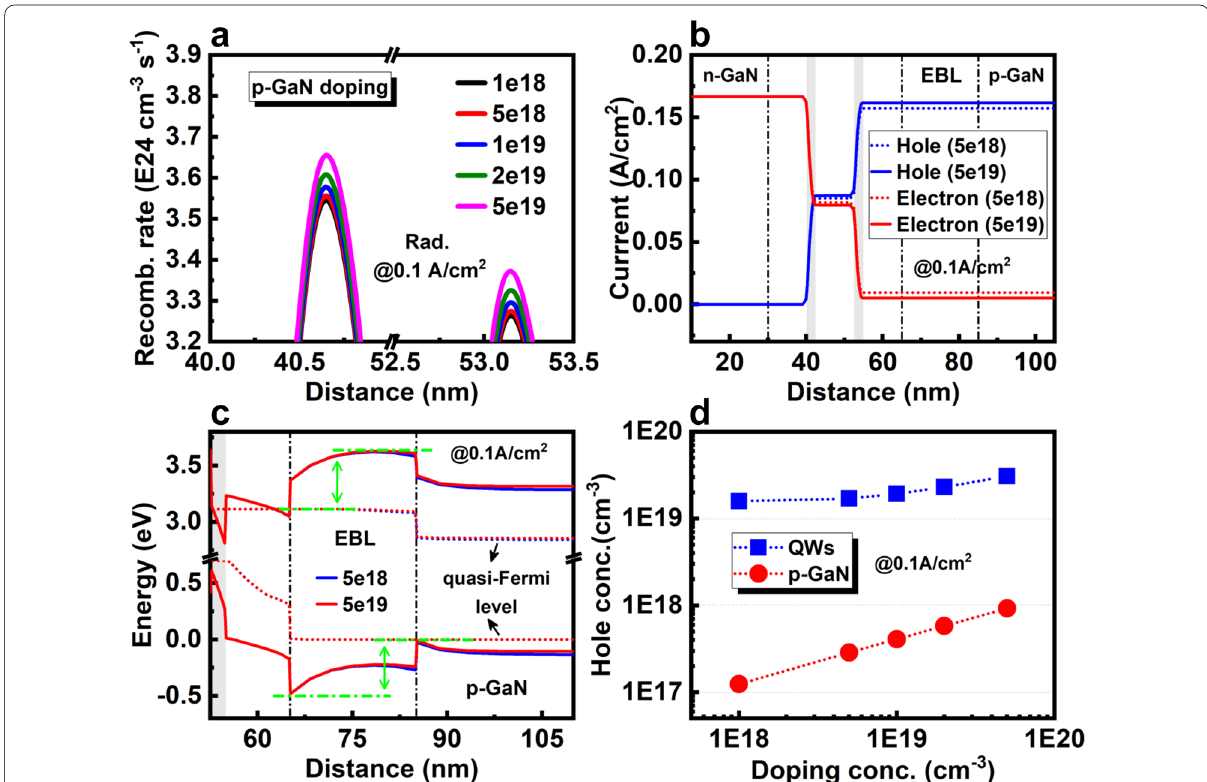
Fig. 6 a Radiative recombination rates of 2QWs LED with various doping concentrations in p-GaN. b Carrier current distribution with different doping concentrations in p -GaN. c Enlarged energy band diagrams of EBL with different doping concentrations in p -GaN. d Average hole concentration in p -GaN and QWs with various doping concentrations of p